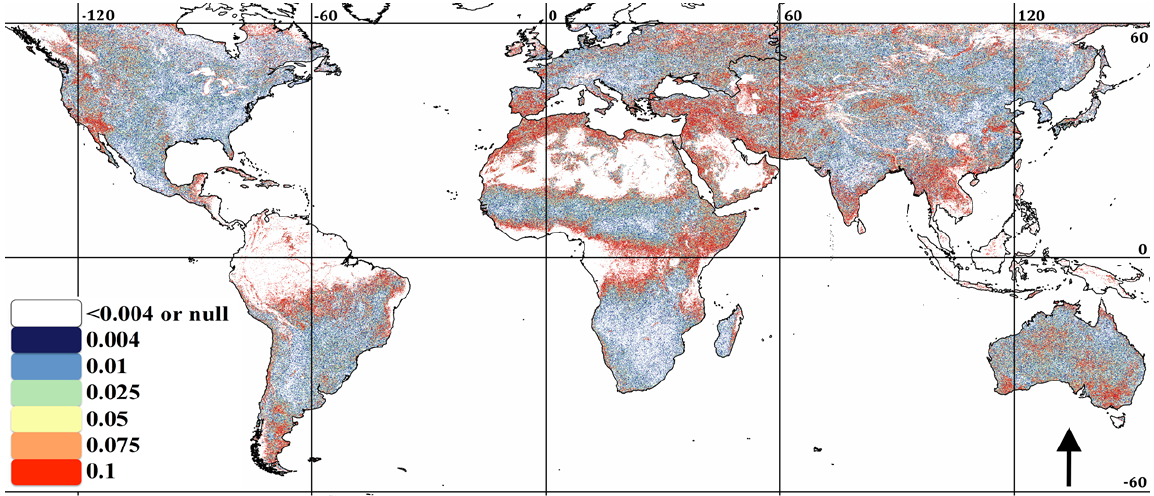
Figure 4. p -values associated with the temperature correlations shown in Figure 2. 1-km